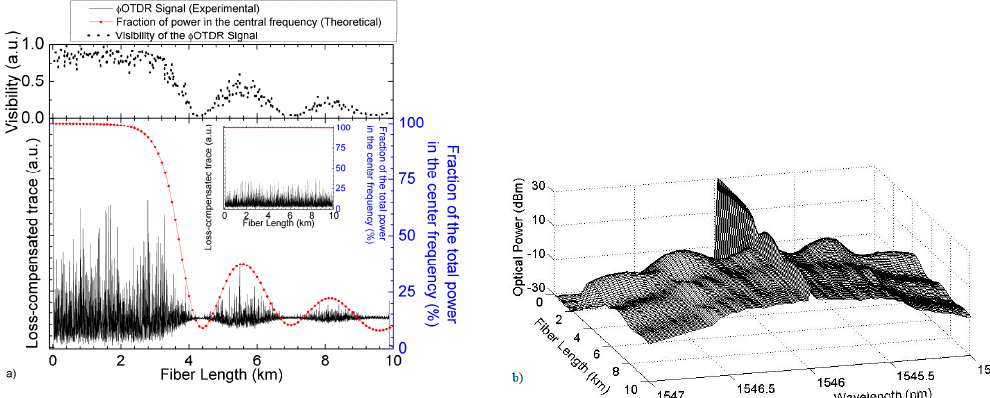
Figure 3. (From [23]) ( a ) Φ OTDR signal along the fibre under test for an input pump peak power of ~1.25 W (main figure) and ~0.35 W (inset figure). Fibre losses have been eliminated along the trace to improve visualization. The theoretical fraction of power contained in the central wavelength is also presented in both cases. The top figure shows the visibility of the Φ OTDR interference signal for the main figure signal. The visibility is computed as V = (T max − T min )/(T max + T min ), where T max and T min are the maximum and minimum values of the trace over a certain distance record (in this case, a window of 40 m); ( b ) Simulation of the input pulse spectrum evolution along the fibre using the parameters used in ( a ). @2013 The Optical Society [23].